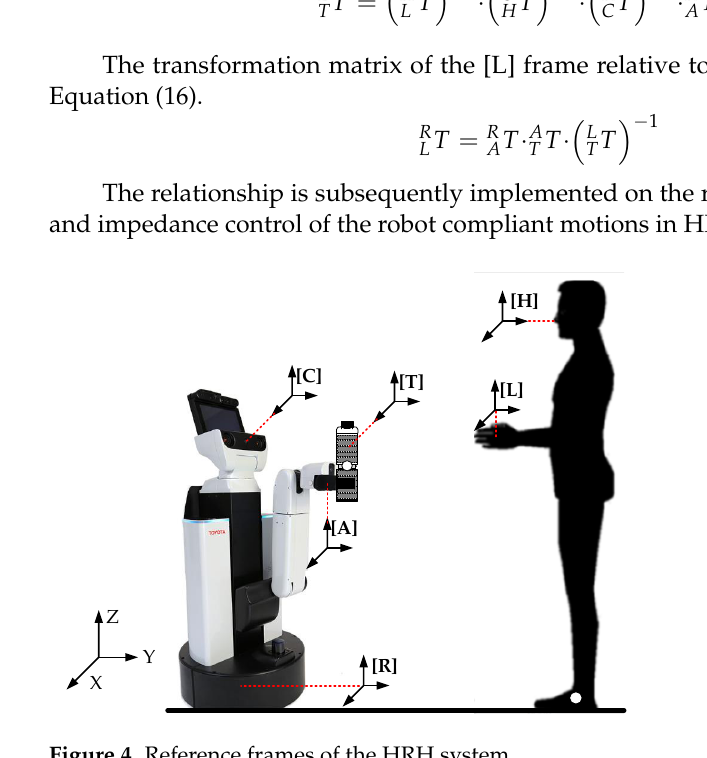
Figure 4. Reference frames of the HRH